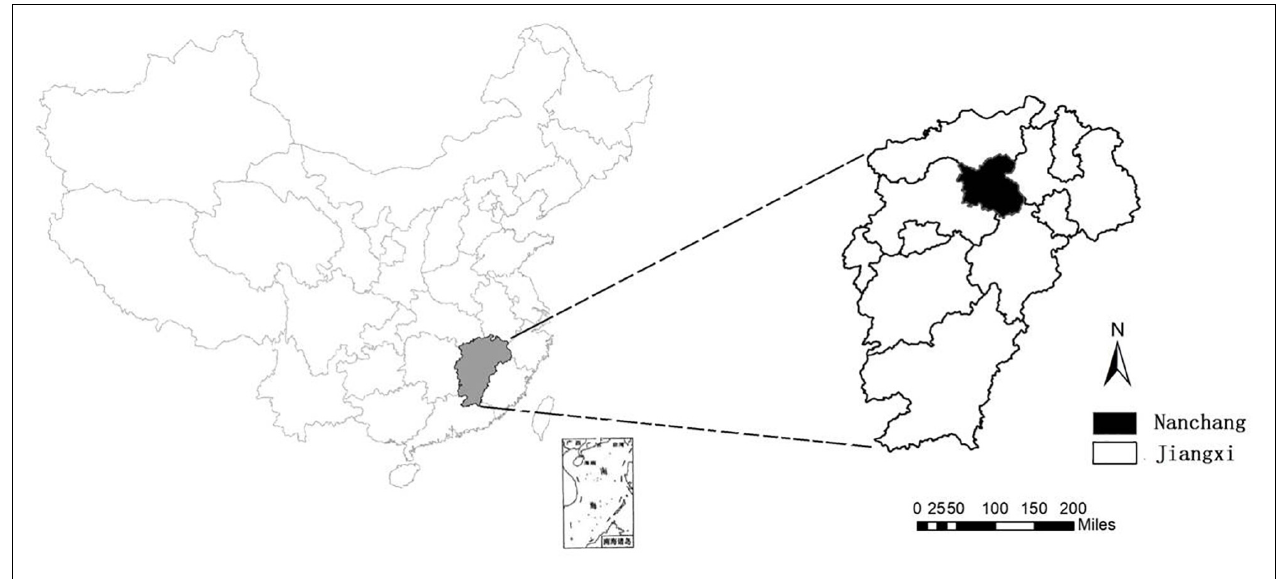
FIGURE 1 | Geographical location of Nanchang City, China.